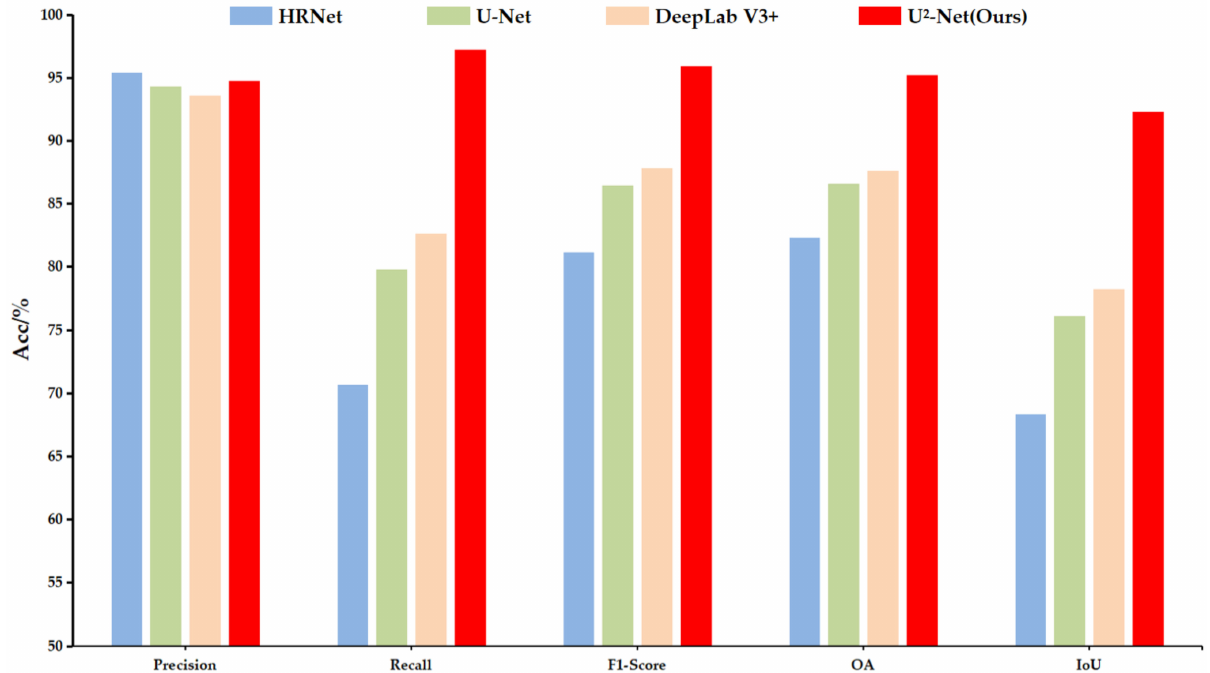
Figure 13. Extraction accuracy of olive tree crown number using different